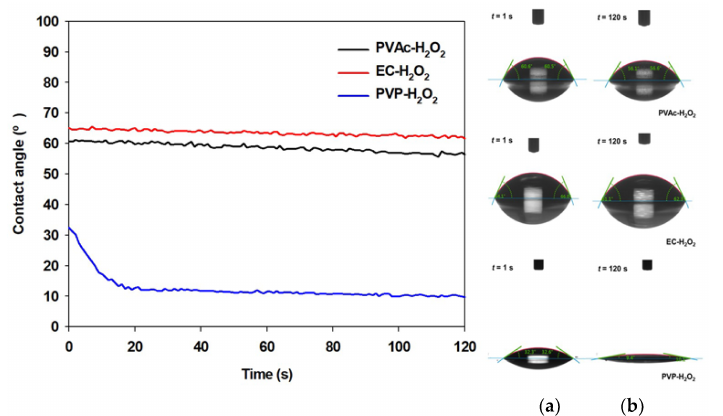
Figure 3. Contact angle plot and photo-images of PVAc-H 2 O 2 , EC-H 2 O 2 and PVP-H 2 O 2 compositions coated on slide glass; ( a ) initial, ( b ) after 120 s.